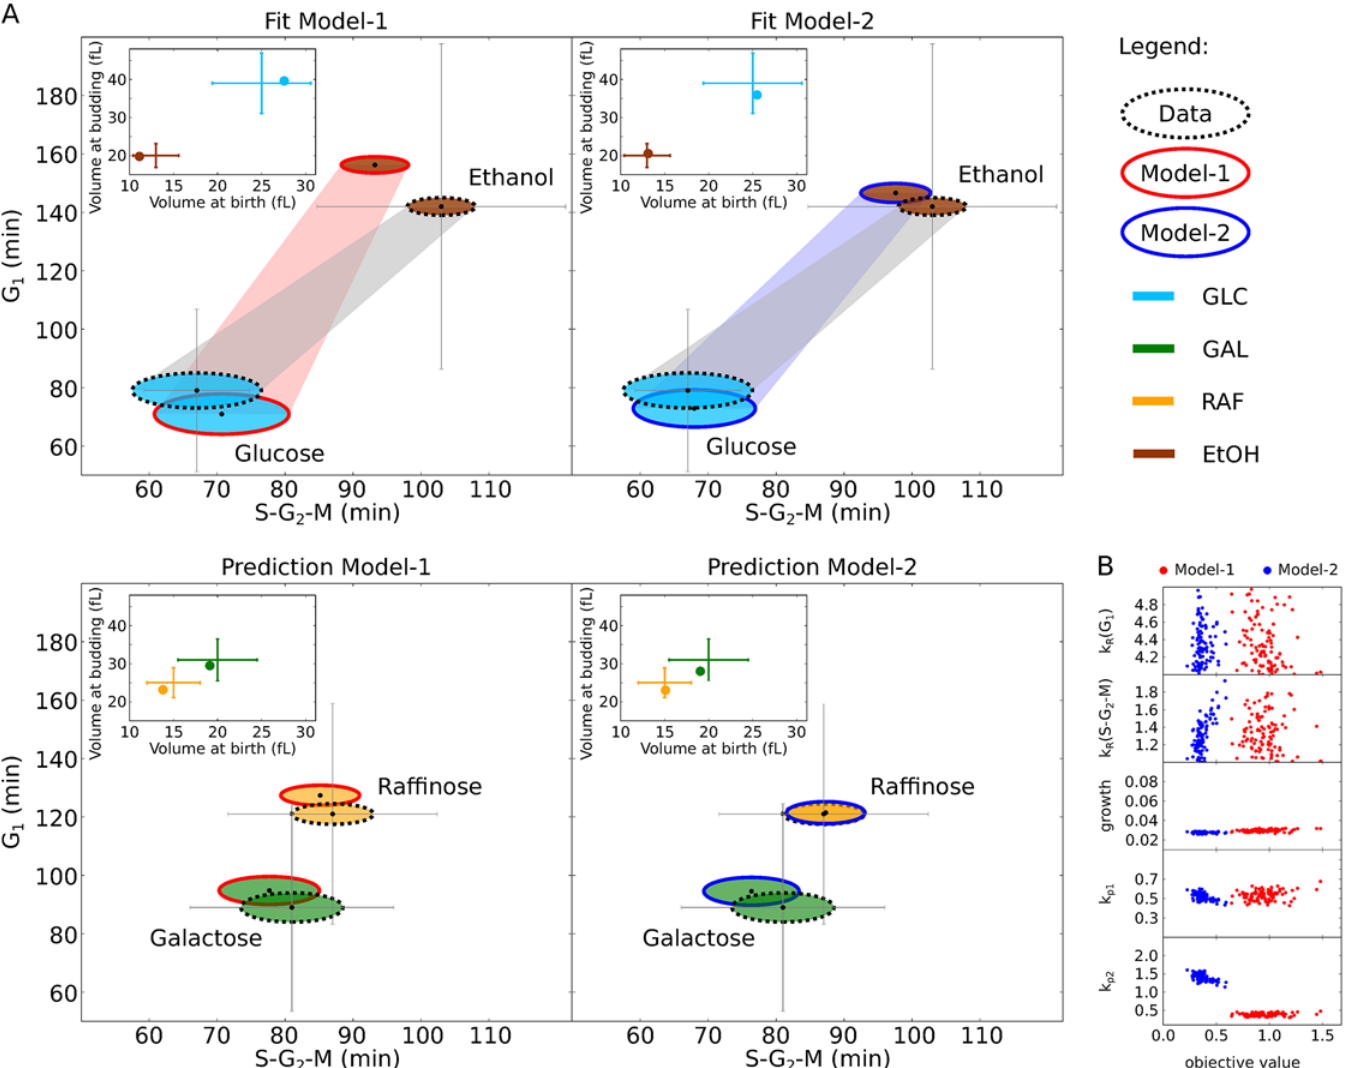
Fig 3. The Models reproduce diverse nutritional conditions. (A) Best fit of Model-1 (left) and Model-2 (right) to cell size and proliferation time data is shown. Proliferation time is indicated as G 1 and S-G 2 -M duration (black dots, grey error bars); corresponding cell size is represented by ovals (oval height: size at birth; width: size at budding). The nutritional conditions glucose (GLC — light blue) and ethanol (EtOH — brown) were used for fitting (top); galactose (GAL — green) and raffinose (RAF — yellow) for model validation (bottom). For clarity, inset figures show volume at birth and at budding again, the values correspond to oval sizes (exp. data: error bars, simulation: dots). A shadow in the top panel indicates how growth and proliferation change over conditions (exp. data: grey, Model-1: light red, Model-2: light blue). All experimental data is taken from [15]. (B) Parameter distributions over objective values (Materials and Methods Eq 4) of 100 independent parameter estimations started from uniformly distributed parameter values within boundaries (y-axis ranges correspond to boundaries, see also Table 2) for Model-1 (red) and Model-2 (blue).